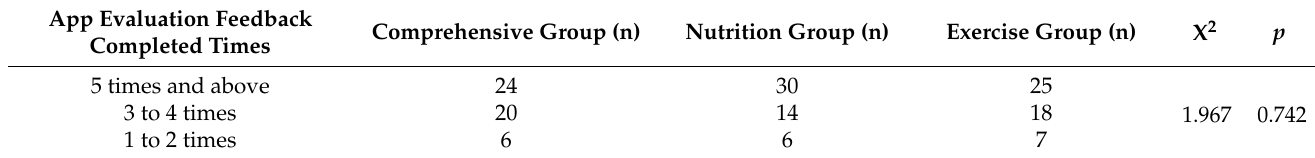
Table 1. Frequency of app feedback/evaluation provided by the different intervention groups.